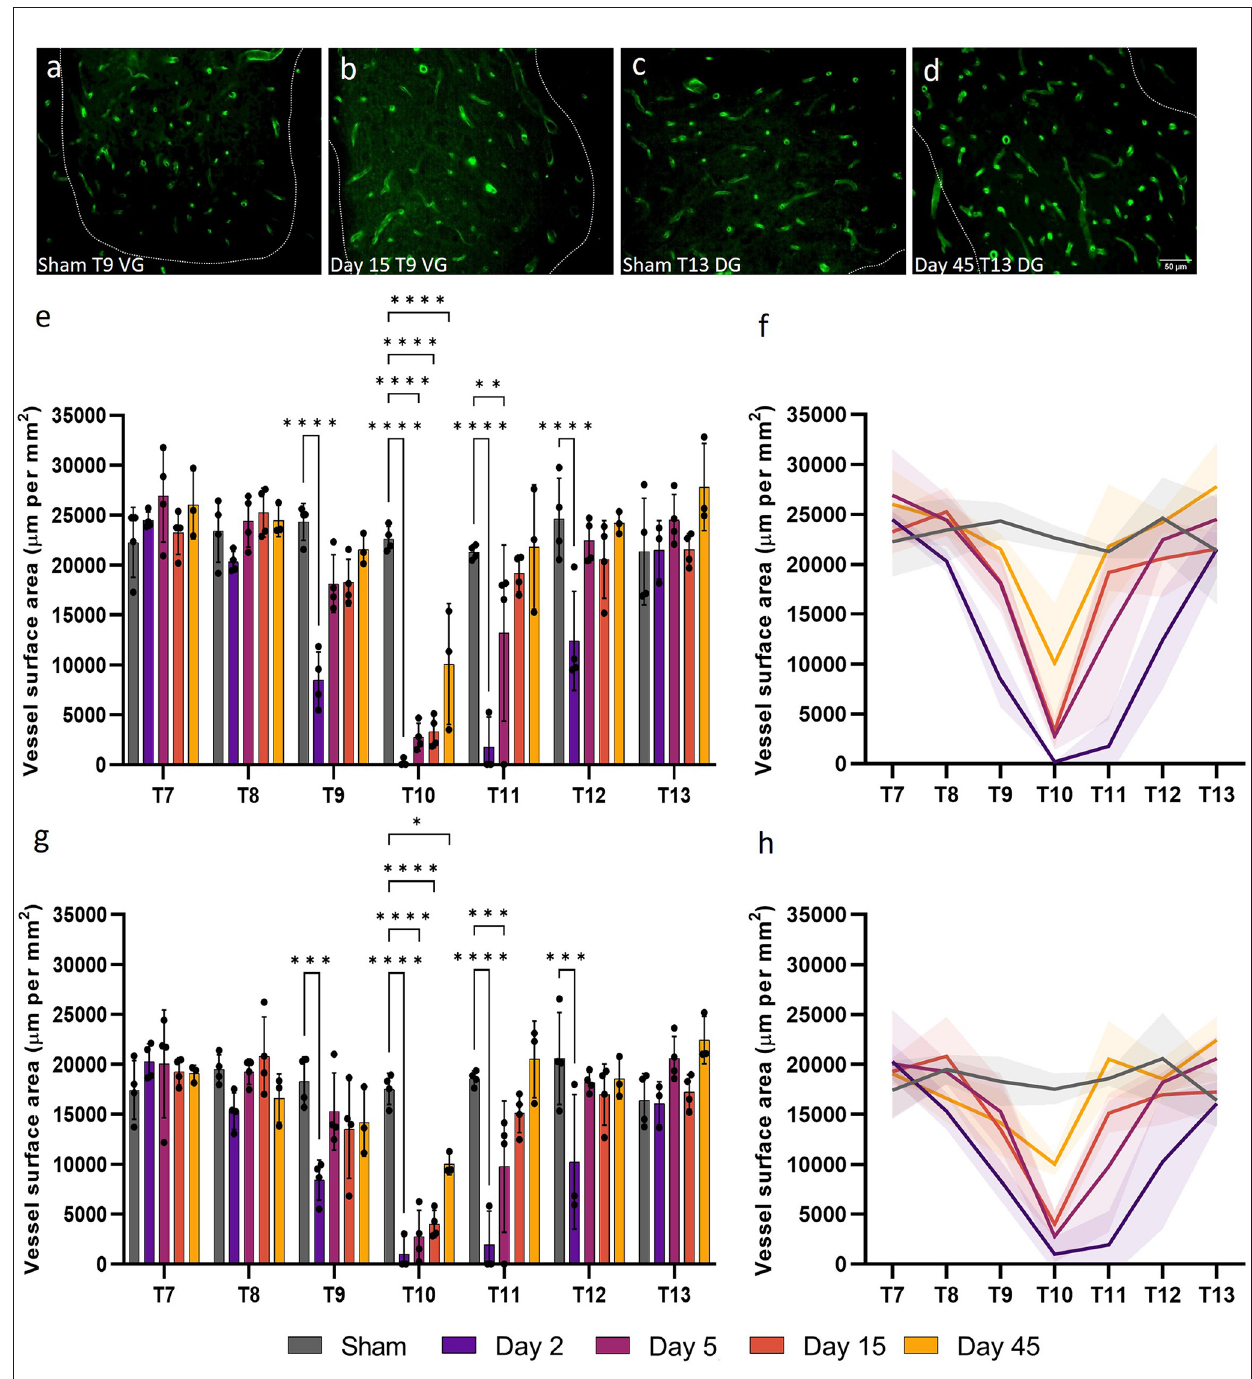
FIGURE2 Widespread microvessel surface area disruption occurred following spinal cord injury. Vessel surface area [visualised by RECA-1 staining (green)] reduced until day 15 in the ventral grey (VG) matter at T9 (B) compared to shams (A) . An increasing trend in vessel surface area was observed at day 45 at T13 in the dorsal grey (DG) matter (D) compared to shams (C) . Spatiotemporal changes in the surface area of vessels were present as far as two spinal segments from the injury epicentre in the ventral grey matter (E,F) and the dorsal grey matter (G,H) . Trend lines (F,H) show the pattern of changes over time across seven spinal segments. Scale bar = 50 µ m (A–D) . ∗ P < 0.05, ∗∗ P < 0.01, ∗∗∗ P < 0.001, ∗∗∗∗ P < 0.0001. Error bars ± SD. n = 3/4 for all groups.